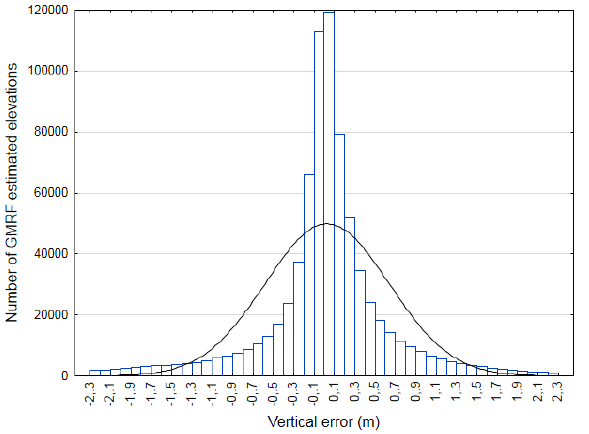
Figure 6. Histogram of vertical error (Z checkpoint – Z DSM ) corresponding to the 1 m grid spacing GMRF DSM. Ratio of observed points = 10% (low density) and σ p = 1 m